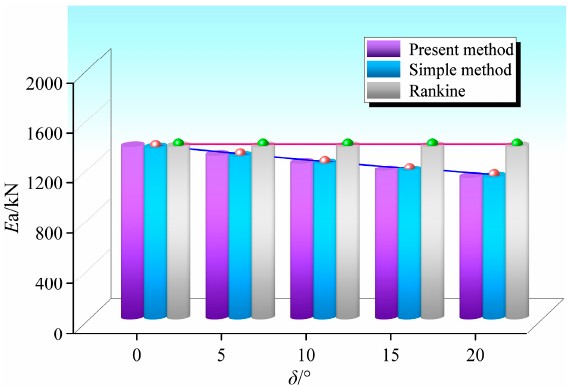
Figure 21. The influence of structure-soil friction angle.